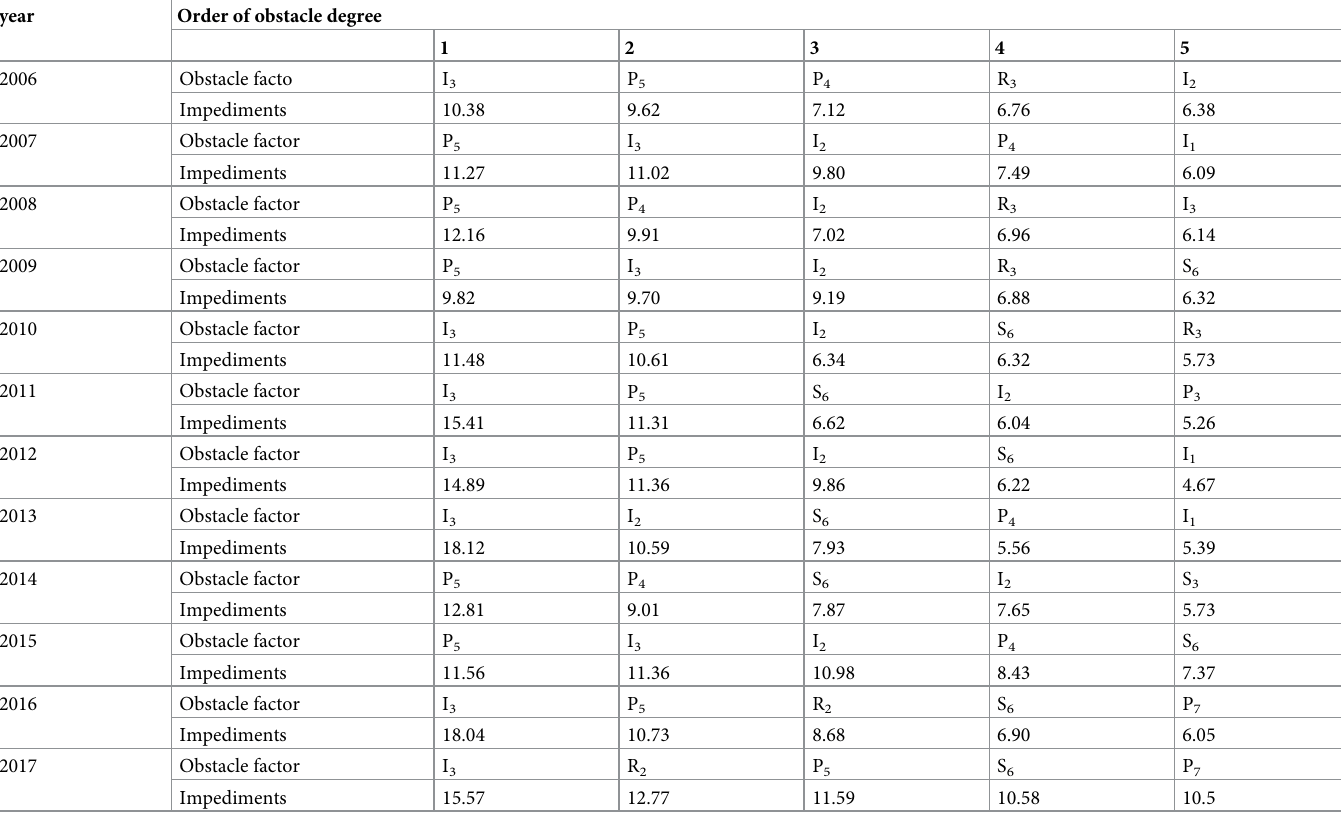
With Eqs (14) and (15), the obstacle degree land-based ecological security evaluation index was calculated for Xingtai city from 2006 to 2017. The results showed that the obstacles for land-based ecological security were dynamic rather than static in Xingtai city. The obstacles change in each year in terms of the categories of obstacles, the size of the obstacle degree and the ranking of obstacles. Because many indexes were selected for the evaluation system, this Table 13. Main obstacles to land-based ecological security in Xingtai